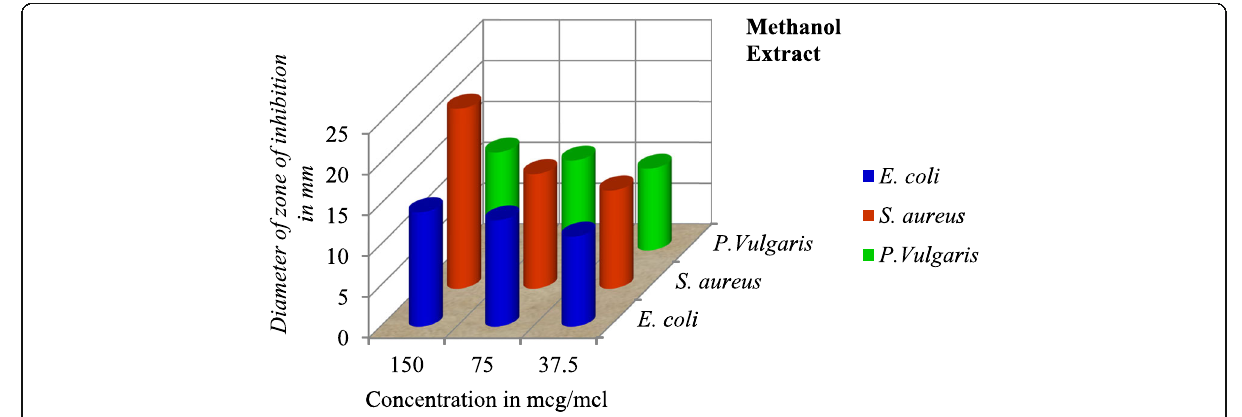
Fig. 3 Antibacterial sensitivity of methanol